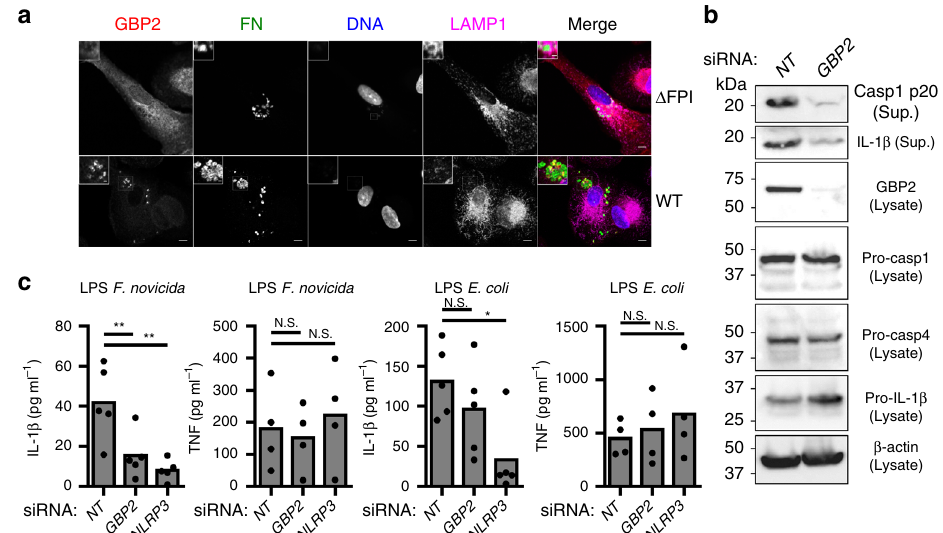
Fig. 8 GBP2 contributes to caspase-4 responses to F . novicida LPS. a hMDMs infected with the wild-type F . novicida strain or the Δ FPI mutant at a MOI of 10 for 9 h were immunostained for F . novicida (FN, green), GBP2 (red), LAMP1 (magenta), and stained with DAPI (blue). Scale bars 5 μ m and 1 μ m in main images and insets, respectively. b , c hMDMs were transfected with non-targeting siRNA (NT) or with the indicated siRNA. b Caspase-1 and IL-1 β processing were evaluated in the supernatant (Sup.) of hMDMs infected with F . novicida at a MOI of 10 for 8 h, one experiment representative of three experiments is shown. c hMDMs were primed with Pam3CSK4 and transfected with 5 μ g.mL -1 of the indicated LPS. IL-1 β and TNF levels in the supernatant were quanti fi ed by ELISA at 20 h post-transfection. Each point shows the mean value from three technical replicates for one healthy donor, the bar shows the mean for all donors ( n ≥ 4). Two-tailed p values with the following nomenclature (** p < 0.01 and * p < 0.05 by paired t -test) are shown. N.S.